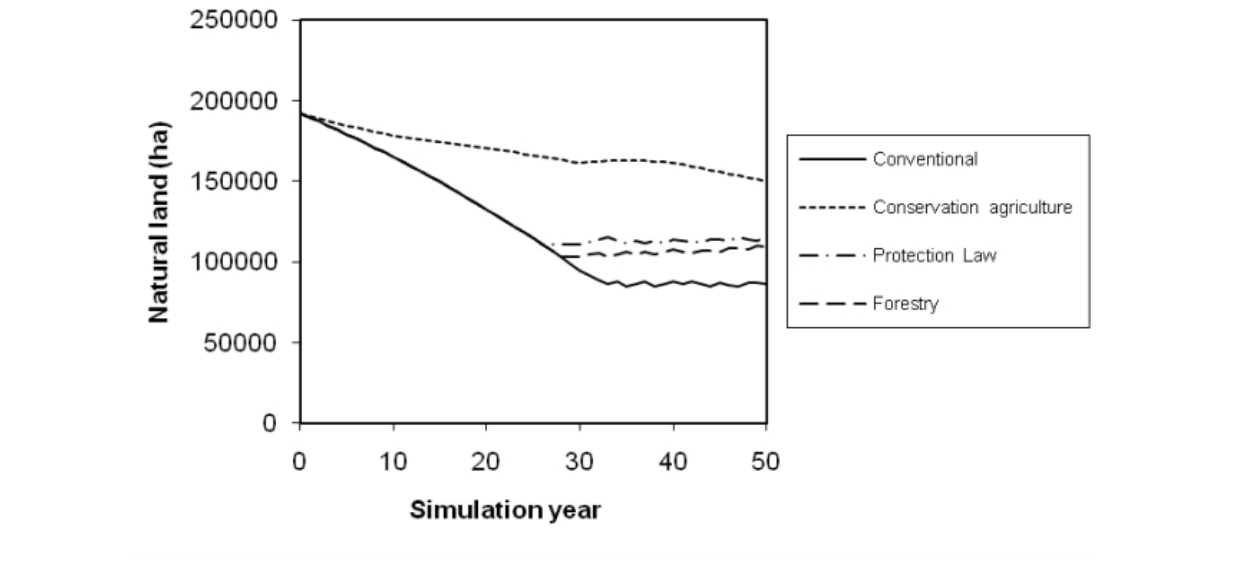
Fig. 3 . Simulated change in natural land in the Cuenca under four land use